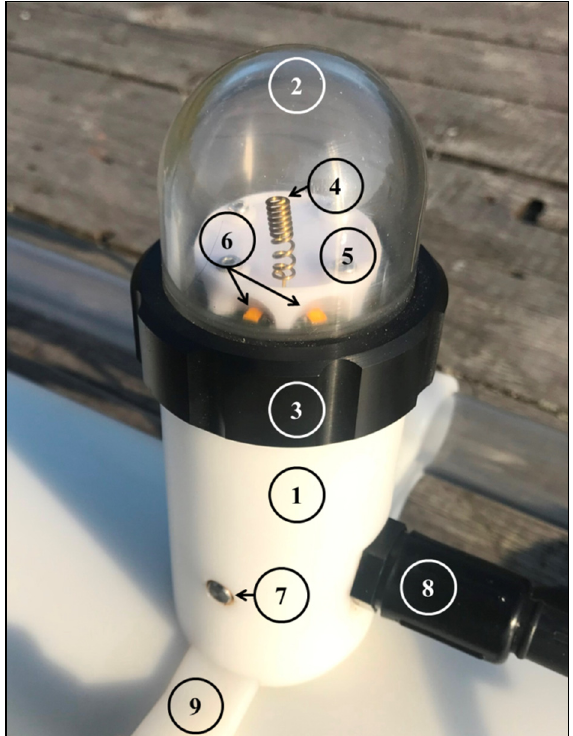
Figure 9. GPS/GSM module of the profiler—Winchi: (1)—pressure-proof housing, (2)—end cap made of acrylic, (3)—cap nut, (4)—GSM antenna (spiral), (5)—light reflector (white plastic caved cover), (6)—LED flashlights (only 2 pieces of the total 8 pieces are shown), (7)—air–sea interface sensor, (8)—data I/O and power connector, and (9)—mounting clamp. The antenna of the GNSS navigation receiver is located behind the light reflector (not shown).